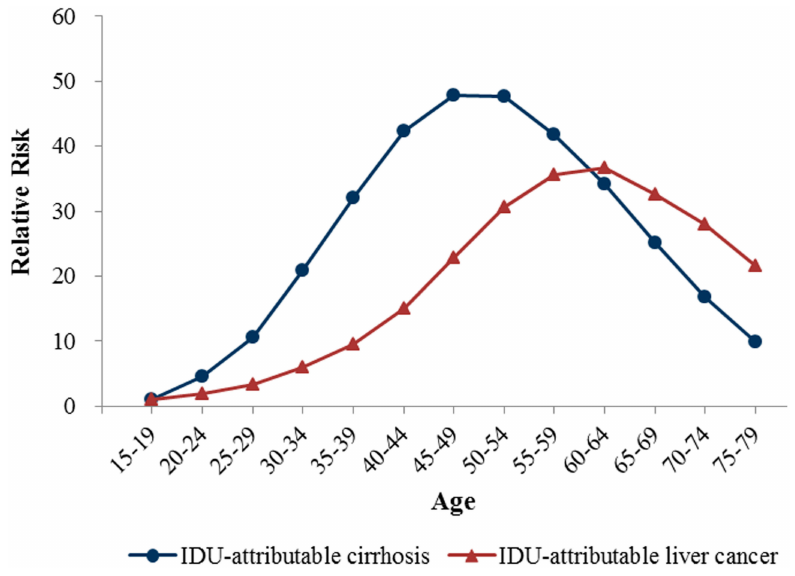
Figure 3. Age effects on mortality rates of IDU-attributable cirrhosis and IDU-attributable liver cancer.